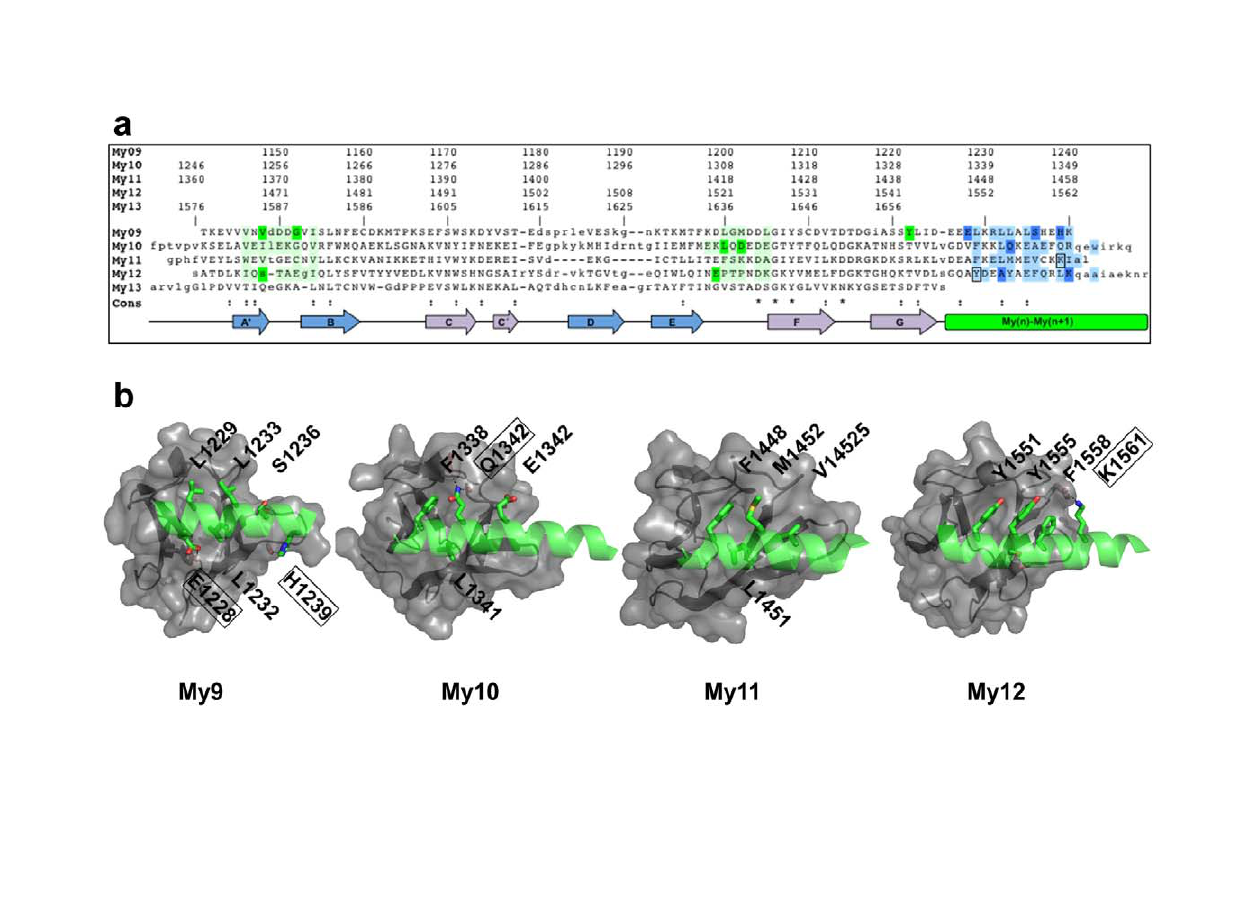
Figure 2. Conserved, repetitive IgH modules of My9, My10, My11, and My12. (A) Structure-based sequence alignment of My9, M10, My11, My12 IgH modules and My13. The residue numbers of each of the five sequences are indicated on top. The approximate locations of secondary structural elements are shown at the bottom (for further details see Figure S2). Highly conserved residues (:) and identical residues (*) are indicated in the consensus sequence line. Those residues that are involved in My domain/helix interfaces are highlighted in complementary colors (dark colors for specific hydrogen bonds, light colors for remaining interactions). The two residues (K1457 and Y1551) that have been mutated for SAXS studies (cf. Figure 3C) are boxed. (B) Structurally conserved My domain/helix interface areas in My9, My10, My11, and My12. Interacting helix residues are labeled; residues are boxed if involved in specific hydrogen bonds.